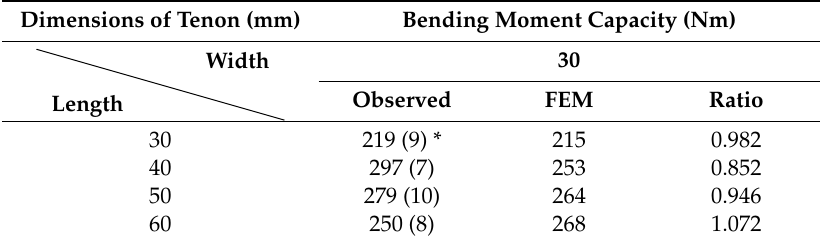
Table 3. Comparisons of bending moment capacities (BMCs) between experiment and FEM.